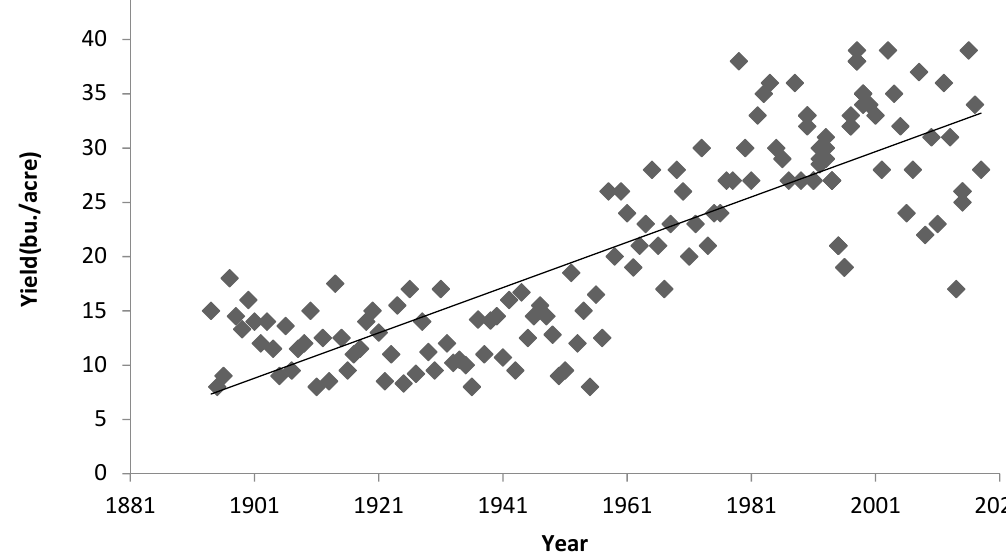
Figure 1. Wheat yields in Oklahoma from 1881 to 2018. Source: USDA-NASS Quickstats (2018) [22].